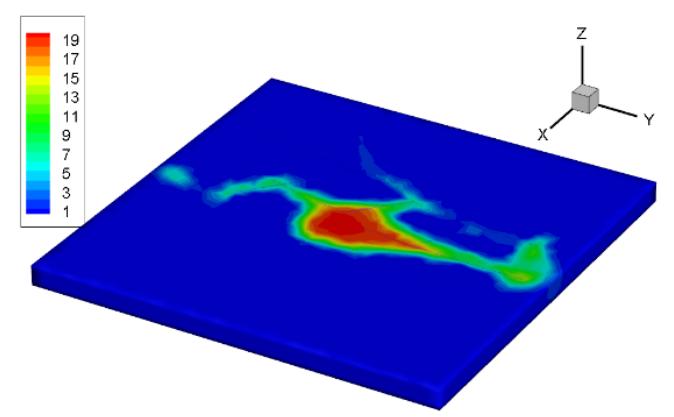
Figure 24. Production rates for well pattern B.